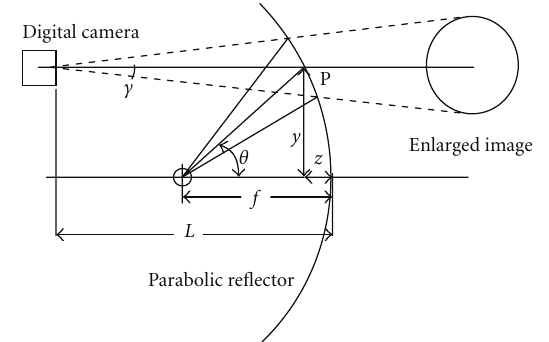
Figure 2: Scheme of the measuring experimental